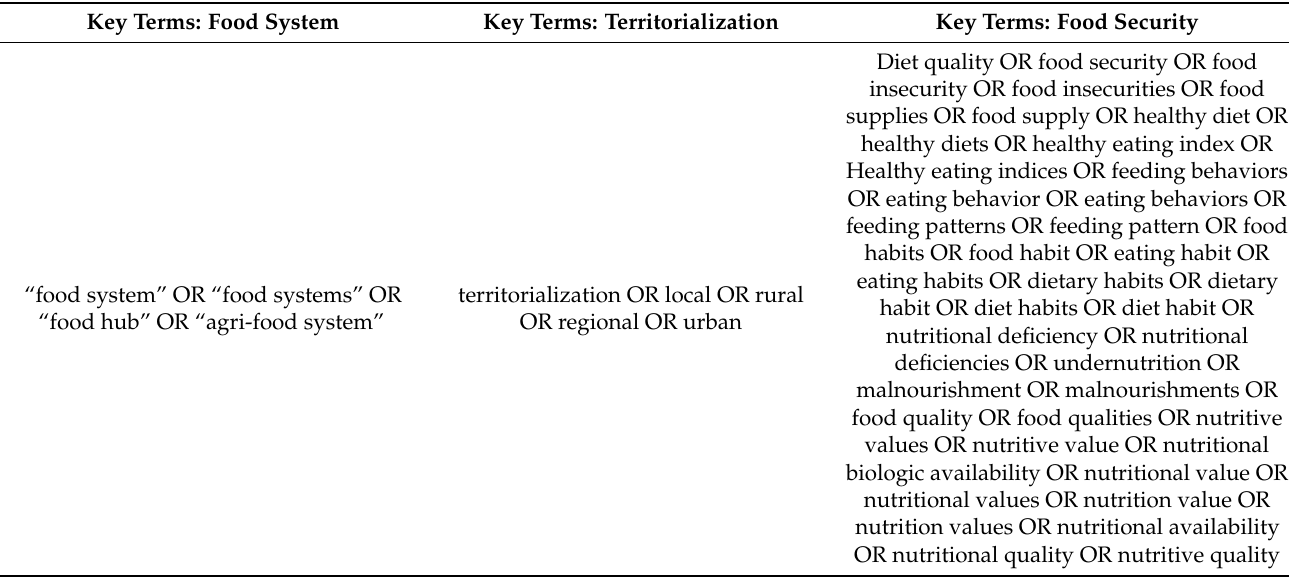
Table 1. Key search terms used in academic databases to identify the literature relevant to food systems, territorialization, and food